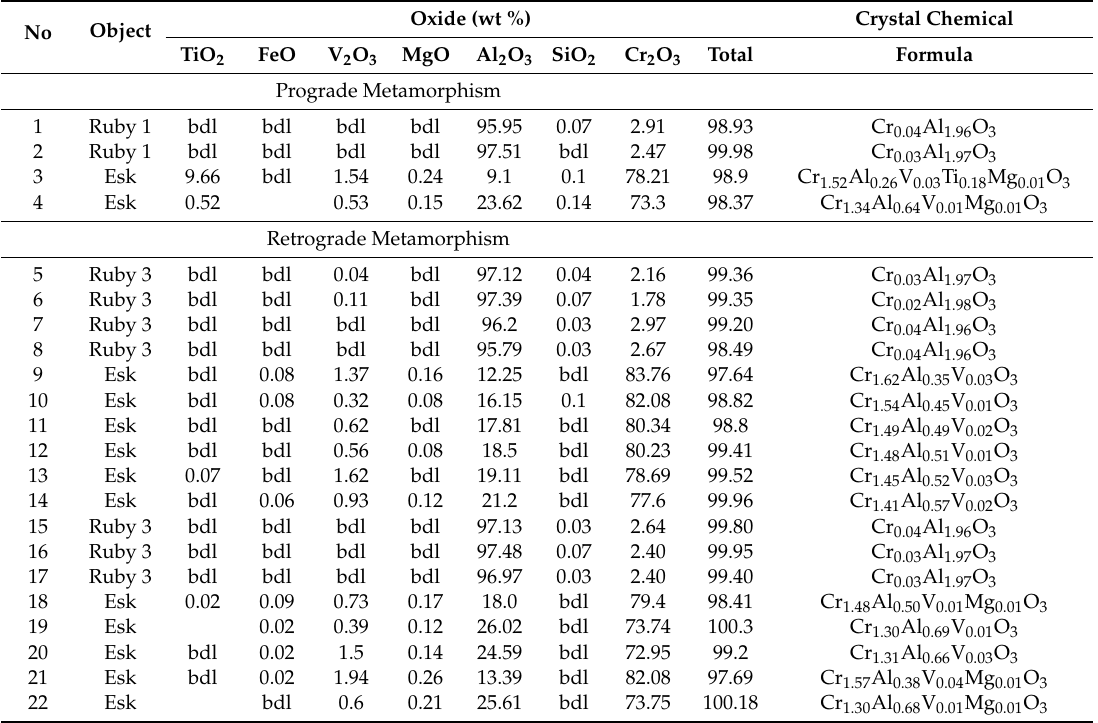
Table 2. The chemical composition of eskolaite and associated ruby of the prograde and retrograde metamorphism according to X-ray